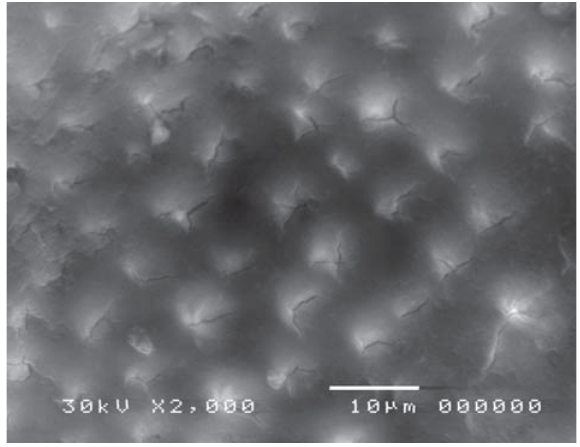
Figure 13- Electron-micrograph in control (CB) group subjected to conventional high speed turbine bur before acid etching showing (cid:87)(cid:75)(cid:72)(cid:3)(cid:71)(cid:72)(cid:81)(cid:87)(cid:76)(cid:81)(cid:68)(cid:79)(cid:3)(cid:87)(cid:88)(cid:69)(cid:88)(cid:79)(cid:72)(cid:86)(cid:3)(cid:82)(cid:85)(cid:76)(cid:191)(cid:70)(cid:72)(cid:86)(cid:3)(cid:90)(cid:72)(cid:85)(cid:72)(cid:3)(cid:85)(cid:72)(cid:79)(cid:68)(cid:87)(cid:76)(cid:89)(cid:72)(cid:79)(cid:92)(cid:3)(cid:70)(cid:79)(cid:82)(cid:86)(cid:72)(cid:71)(cid:3)(cid:11)(cid:91)(cid:21)(cid:15)(cid:19)(cid:19)(cid:19)(cid:12) Figure 14- Electron-micrograph in control (CB) group subjected